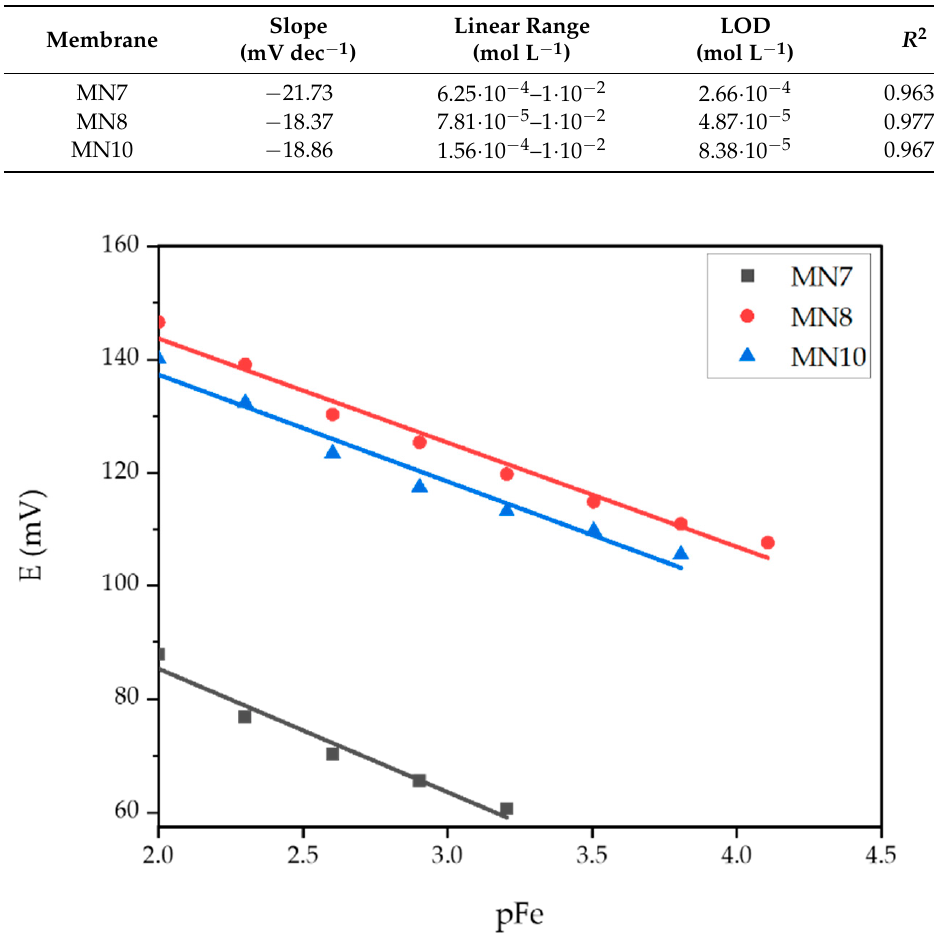
Figure 13. Potential change dependence of pFe evaluated for MN7, MN8, and MN10 membranes. The MN7 membrane with an addition of 0.25% alumina NPs showed a linear response to ferric cations in Fe(NO 3 ) 3 solution at pH 1. The recorded slope was − 21.73 mV per decade with a correlation factor of 0.9635. The addition of a larger amount of alumina NPs in the MN8 membrane (0.5%) had a positive effect on extending the linearity range of the membrane. Accordingly, the linearity of this membrane was measured in a concentration range from 7.81 · 10 − 5 mol L − 1 to 1 · 10 − 2 mol L − 1 . The slope obtained in the mentioned concentration range was − 18.75 mV per decade with a correlation factor of 0.9774. There- fore, it is obvious that the increased content of alumina NPs had a positive effect on the membrane properties, considering the increase of the linear dynamic range for the whole decade as well as the sensitivity. The membranes MN7 and MN8 did not show signifi- cant results at pH 5. On the other hand, the MN10 membrane with an addition of 0.25% boehmite NPs showed linearity in the determination of ferric cations in the concentration range of 1.56 · 10 − 4 –1 · 10 − 2 mol L − 1 with a slope of − 18.86 mV per decade and a correlation factor of 0.9674, while tested in acetic buffer at pH 5. The detection limit for this